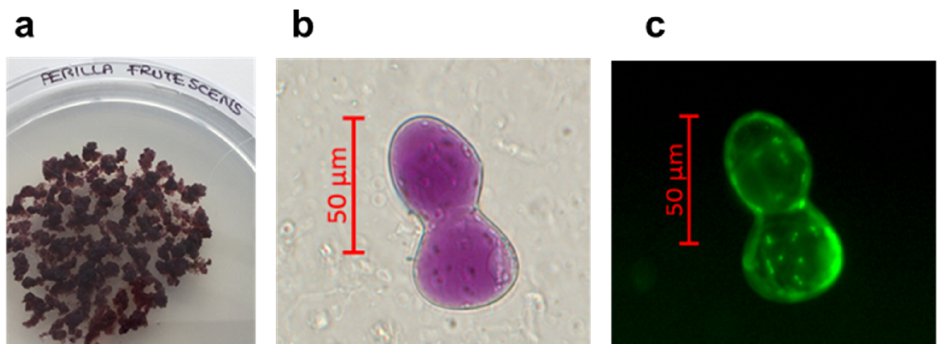
Figure 1. Perilla frutescens (L.) Britton cell culture maintained in solid perilla medium ( a ), optical images of Perilla frutescens cells observed by AXIO-Imager A2 optical microscope (ZEISS), in the bright field mode ( b ), and after staining with fluorescein diacetate ( c ). Scale bar: 50 µm.